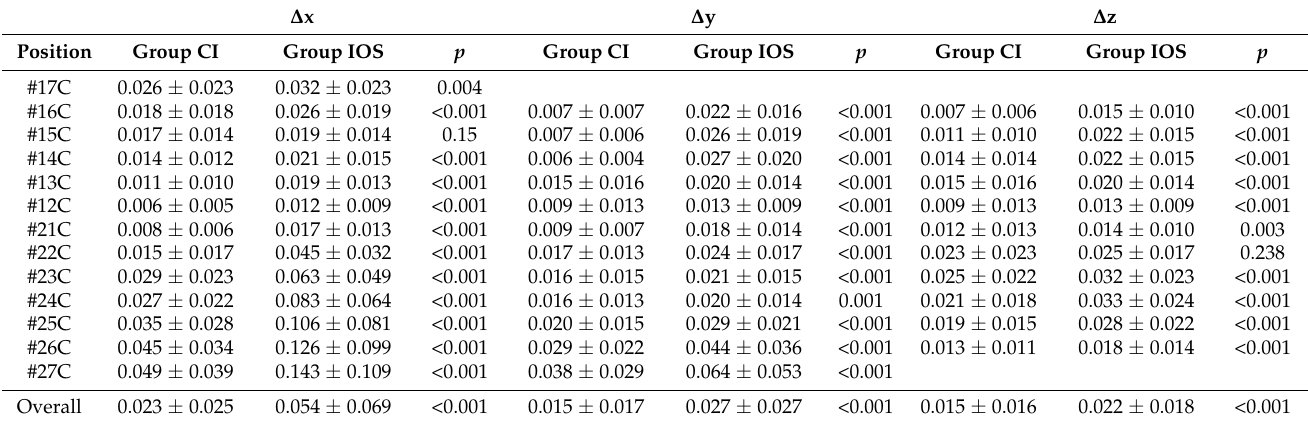
Table 4. Mean precision values and standard deviations